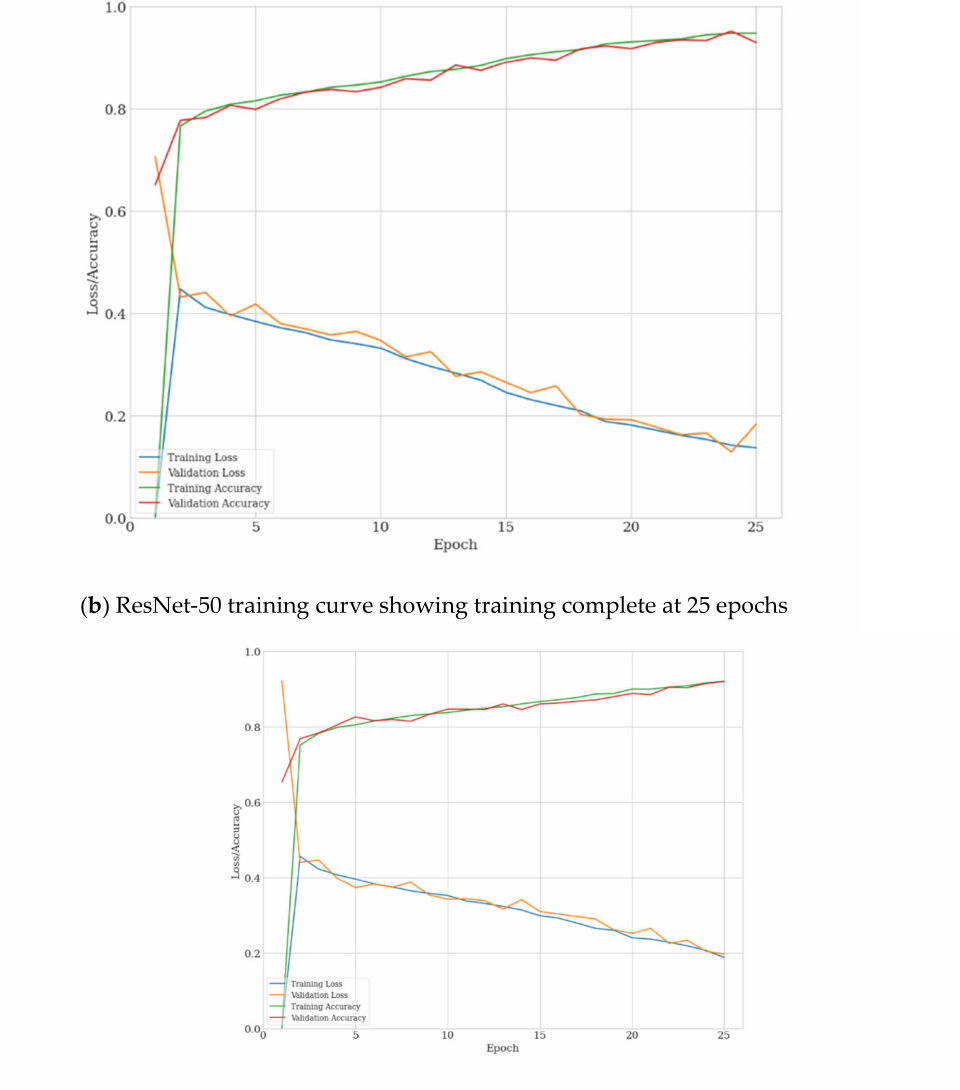
Figure 3. Training and validation loss/accuracy curves for DenseNet-121 ( a ), ResNet-50 ( b ), and ResNet-50 with Triplet Attention ( c